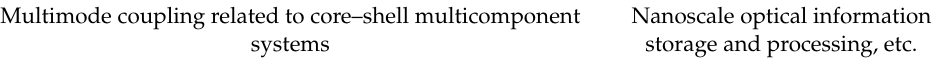
Table 1. Different multimode coupling with their applications. Different Multimode Coupling Applications Coupling related to TMDs microcavity nanostructure Coupling related to single-dye Multimode Coupling microcavity nanostructure related to microcavity Coupling related to two-dyes nanostructure microcavity nanostructure Coupling related to periodic noble metallic nanoparticles- J-aggregates nanostructure Multimode coupling related to core–shell multicomponent systems